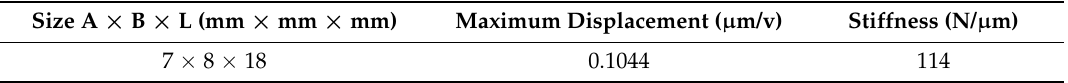
Table 1. Piezo stacks technical parameters.